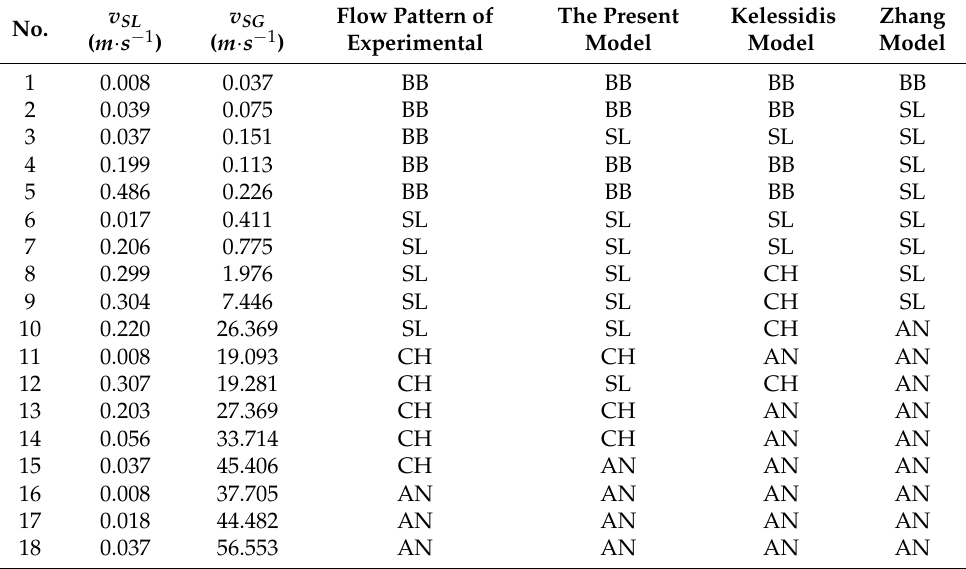
Table 4. Comparison of model predictions with experimental results at an inclination angle of 45 ◦ .